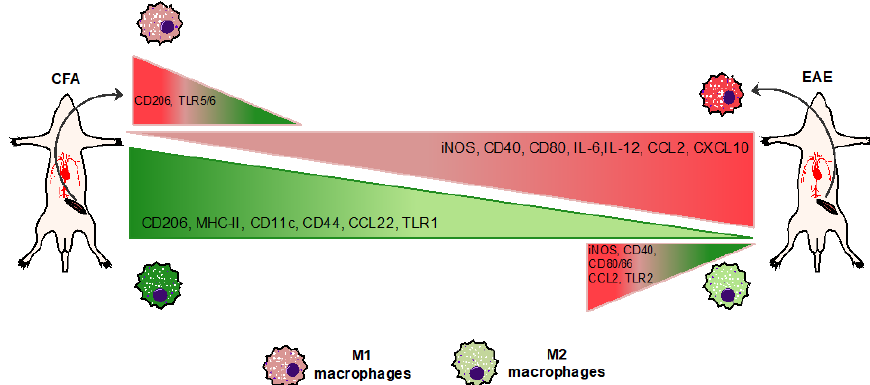
Figure 8. Summary of M1/M2-Mϕ immunophenotype in CFA and EAE mice. Induction of EAE delineates an ex vivo immunophenotypic alteration of M1/M2- Mϕ, with M1 being hyperactive and more pro-inflammatory while M2 being less protective. Supplementary Materials: T he following are available online at www.mdpi.com/xxx/s1, Figure S1: Immunophenotype of macrophages obtained from CFA and EAE mice. Figure S2: Immunophenotype of MOG-immunized M1 and M2 macrophages obtained from CFA